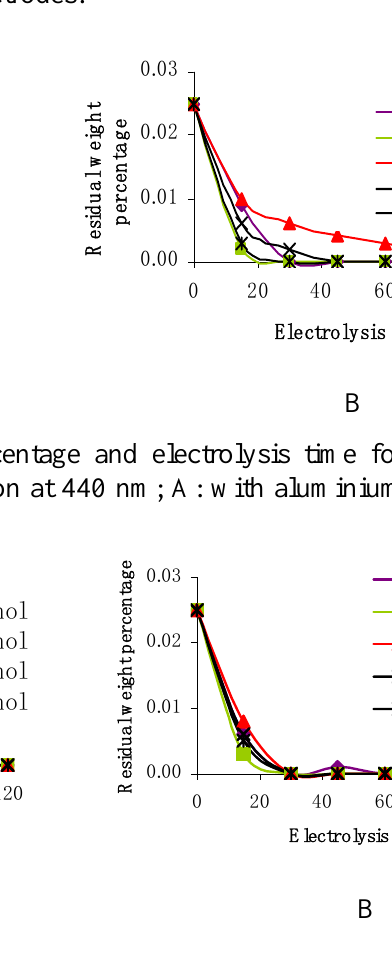
Figure 1. Plots of residual weight percentage and electrolysis time for each ethanol concentration of chlorophyllin solution at 626 nm; A: with aluminium as electrodes, B: with iron as electrodes.